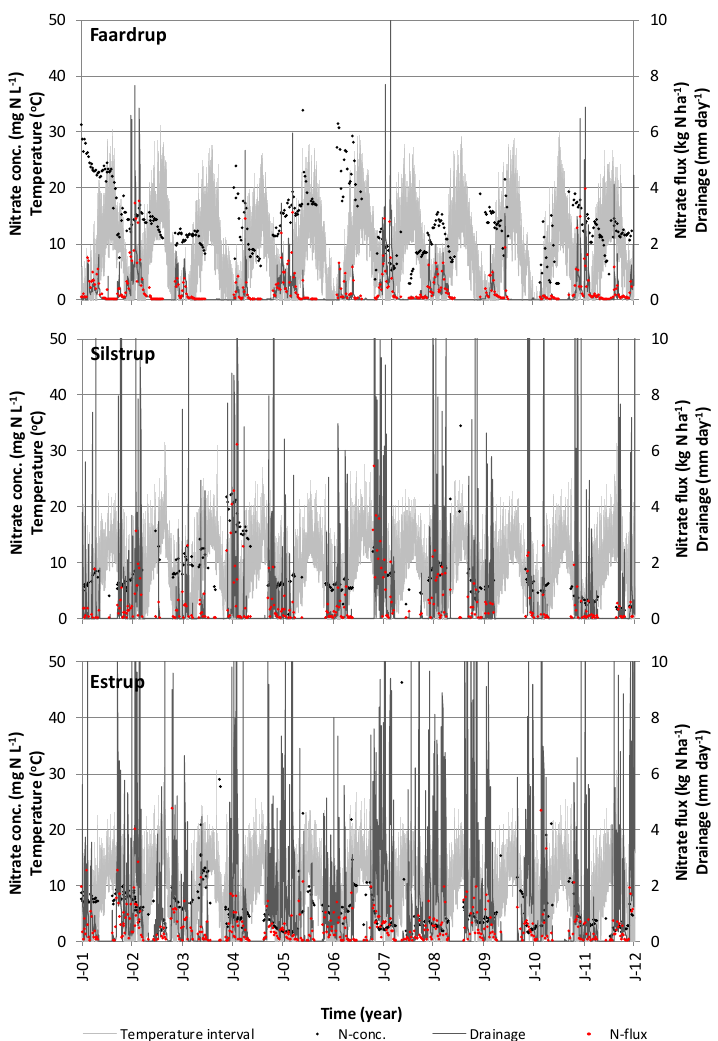
Figure 2. Concentration of nitrate-N, nitrate-N fluxes, drainage and the daily minimum-maximum temperature span for temperatures above zero degrees Celsius for 2001–2012 at Faardrup, Silstrup and